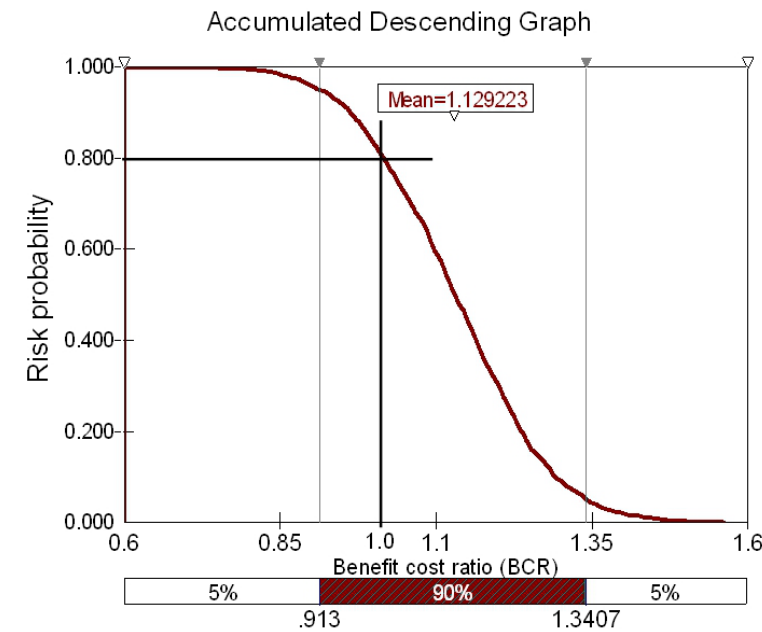
Figure 9. Resulting accumulated graph illustrating the variation of the BCR (Salling 2008) The s -curve presented illustrates the output distribution from the QRA enabling the decision- makers to compare the overall associated risks within the modelling result. The advantage is the illustration of probability of occurrence, a relative measurement of each possible outcome. Figure 9 illustrates the benefit-cost ratio (BCR) depicting a socio-economic profitable project for values exceeding 1.0. The intersection between the vertical and horizontal line is where the BCR equals 1.0. By moving the horizontal line downwards lowers the risk and the corresponding rate of return increases. Decision-makers that allow high risks will “benefit” in higher rates of return and vice versa. Furthermore, the FRA allows for more than one impact to be assessed within the risk analysis. It should be further noted that for the accumulated descending graph with the probability on the y-axis and the BCR on the x-axis, more reliable data will lead to steeper curves. Hence, the input range would be